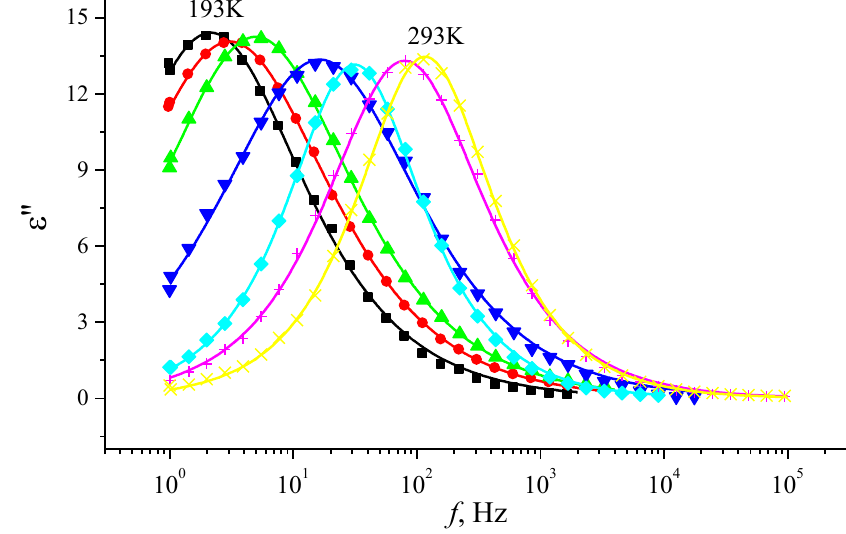
Figure 4. Frequency dependence of the dielectric loss factor ε ” of por-Si layers at different tempera- tures: T = 193 K (black line), 203 K (red line), 213 K (green line), 223 K (blue line), 233 K (light blue line), 272 K (purple line), 293 K (yellow line).